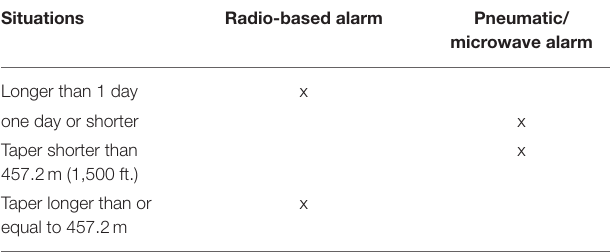
TABLE 3 | Selection guide for work zone intrusion detection devices.